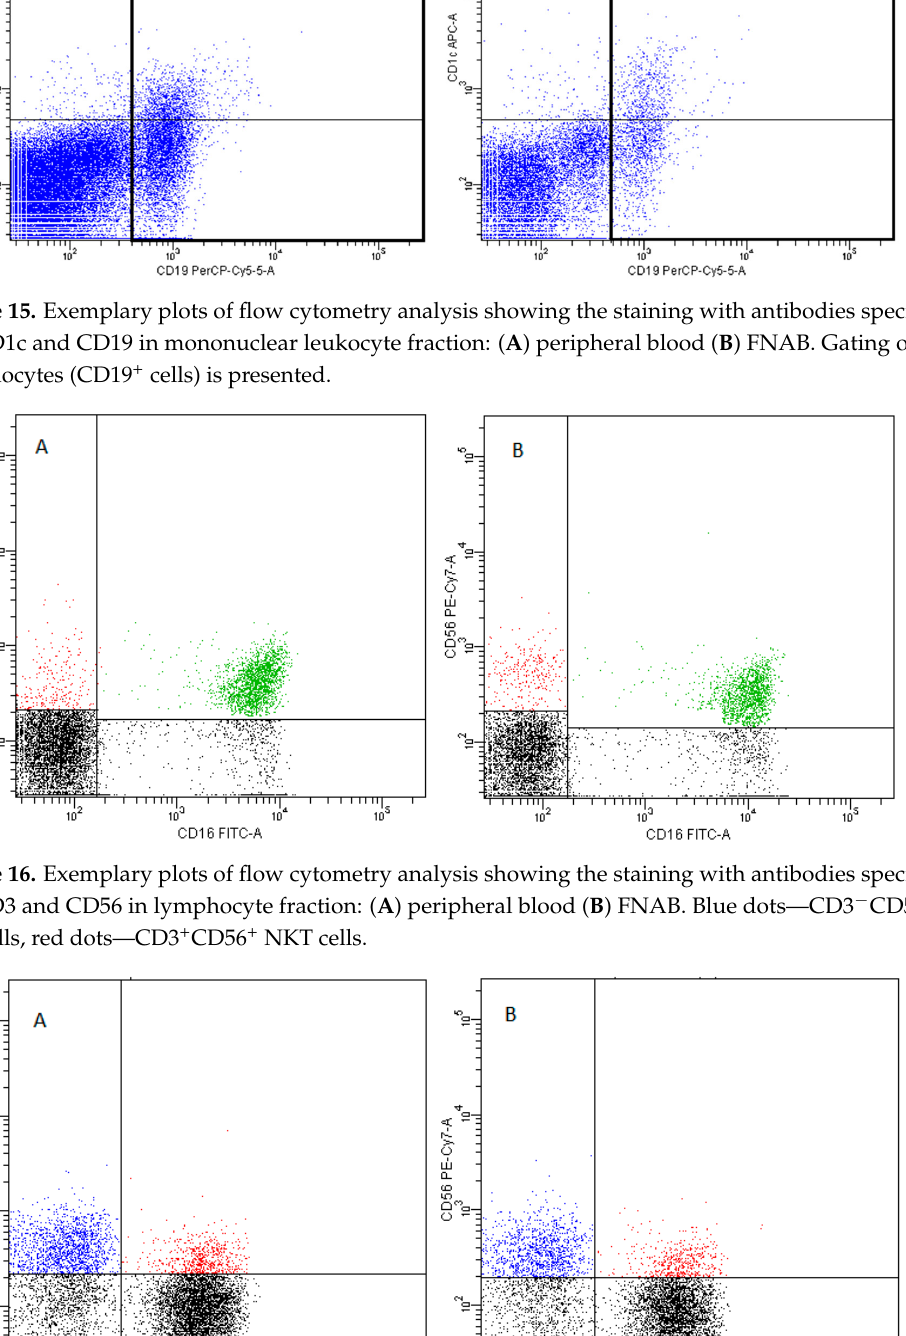
Figure 17. Exemplary plots of flow cytometry analysis showing the staining with antibodies specific for CD56 and CD16 in lymphocyte fraction: ( A ) peripheral blood B. FNAB. Red dots—CD3 − CD56 + CD16 − NK cells, green dots—CD3 − CD56 + CD16 + NK cells.